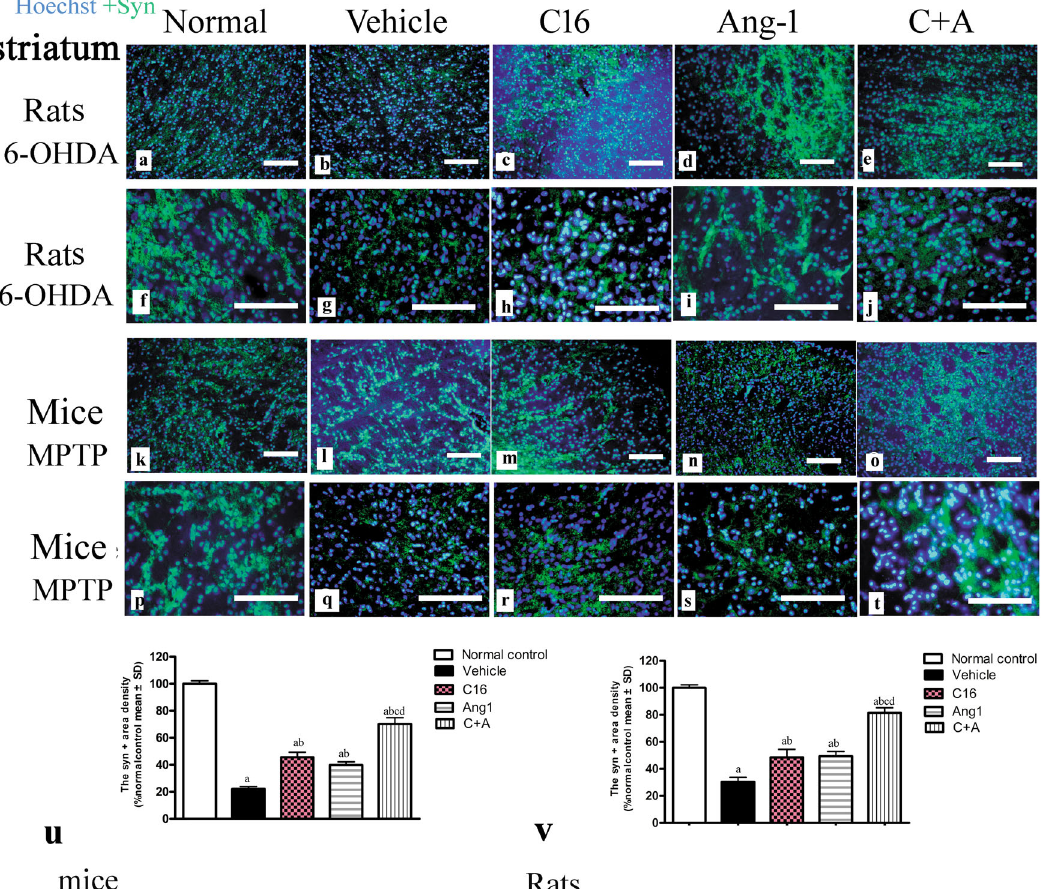
Ang-1 remarkably reversed this phenomenon in both models ( u , v ). The nuclei of cells were stained using Hoechst 33342 (blue). a p < 0.05 versus the normal control group; b p < 0.05 versus the vehicle group; c p < 0.05 versus the C16-treated group; d p < 0.05 versus the Ang-1- treated group. Scale bar = 100 μ m. Syn, synaptophysin; C16, peptide (KAFDITYVRLKF) that can selectively bind integrin α ν β 3 ; Ang-1,